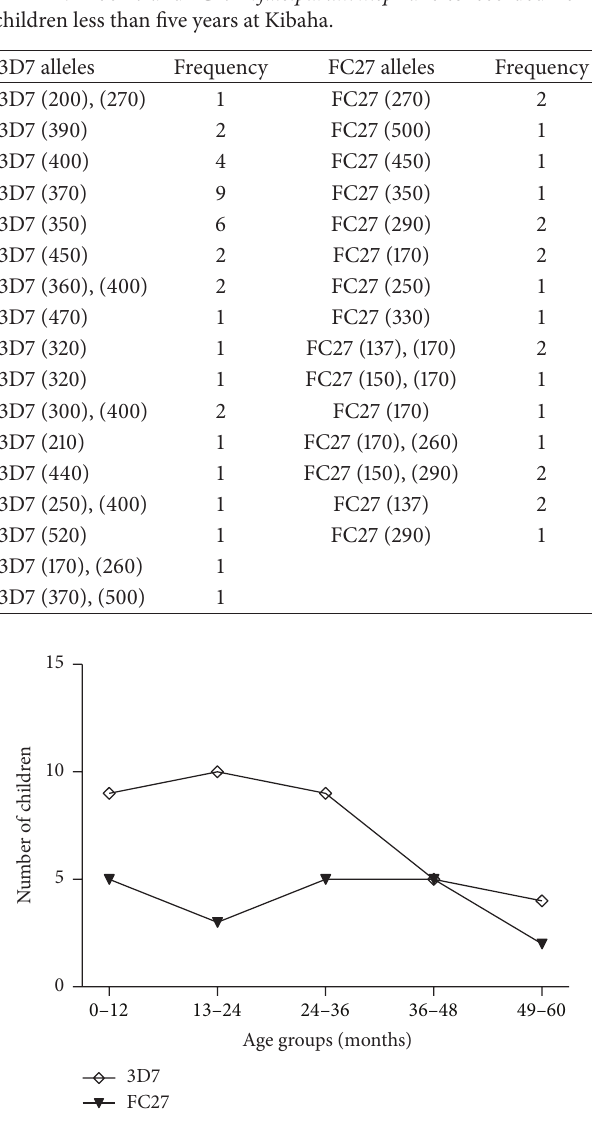
Figure 3: Distribution of msp2 genotypes among children of different age groups at Kibaha at baseline ( 𝑁 = 65 ).